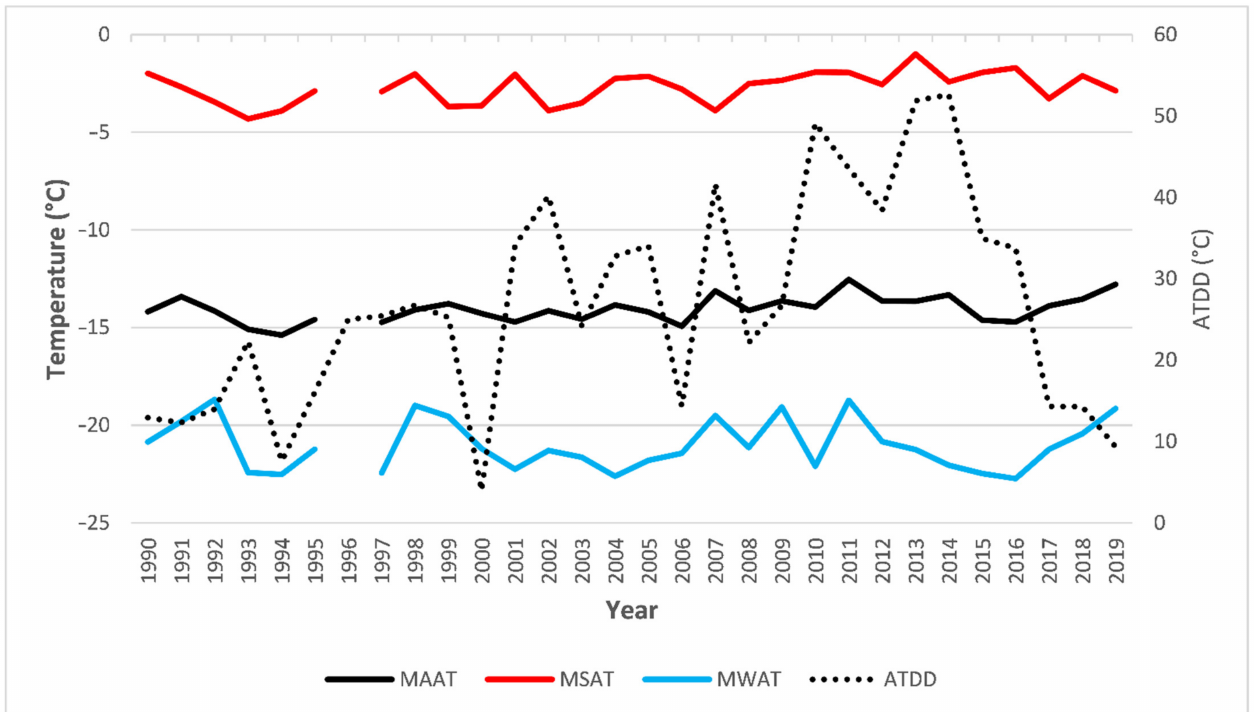
Figure 3. Trends of the principal climatic parameters for the period 1990–2019 at the closer available automatic weather station (AWS) “Eneide” 5 km far from the analyzed lake at Boulder Clay. Legend: MAAT = mean annual air temperature; MSAT = mean summer air temperature (DJF); MWAT = mean winter air temperature (JJA); ATDD = annual thawing degree